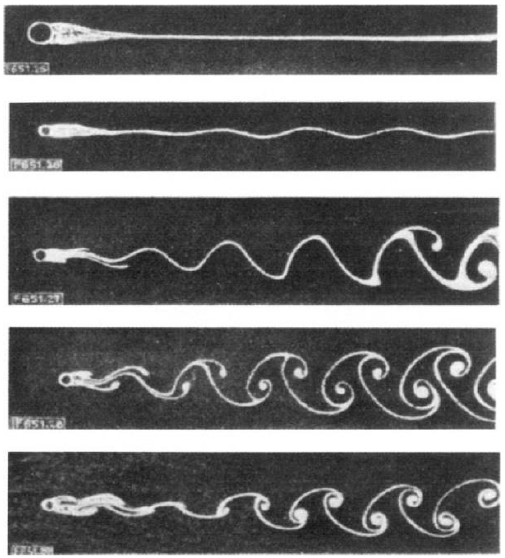
Figure 11. Vortex Street mechanism (reproduced from [42], with permission of Elsevier 2018).